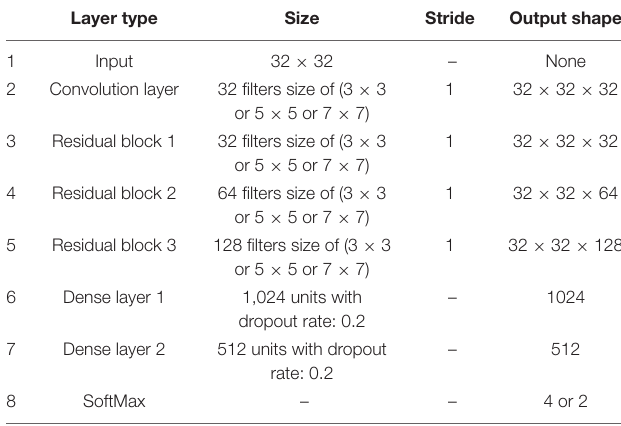
TABLE 4 | The hyper parameters of the proposed BC-DA-RCNN model.